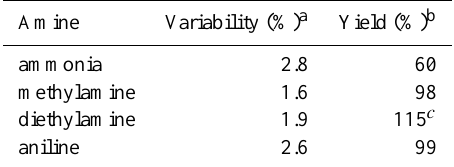
Table 2. Reproducibility and Yield of the Optimized DNFB Amine Derivatization Method. Yields are calculated based on recovery of derivatized products relative to standards of authentic samples of known